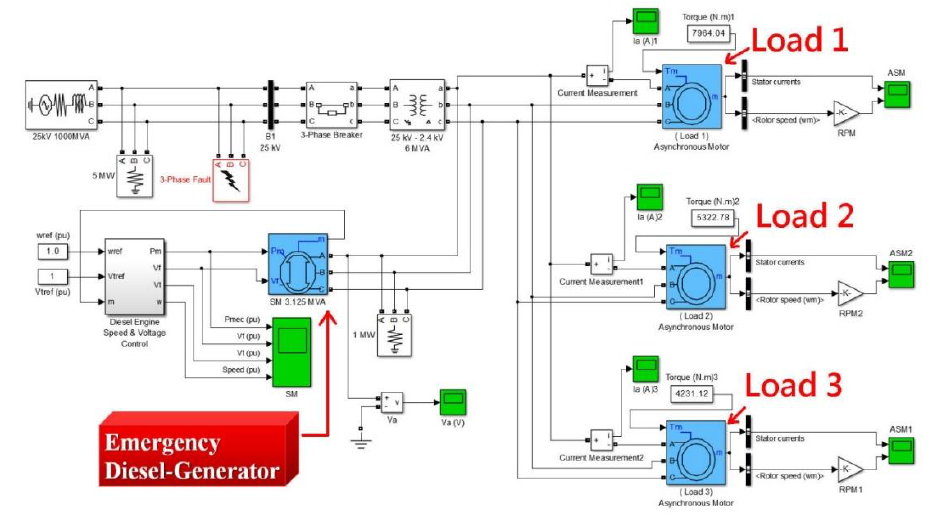
Figure 43. Factory load wiring diagram